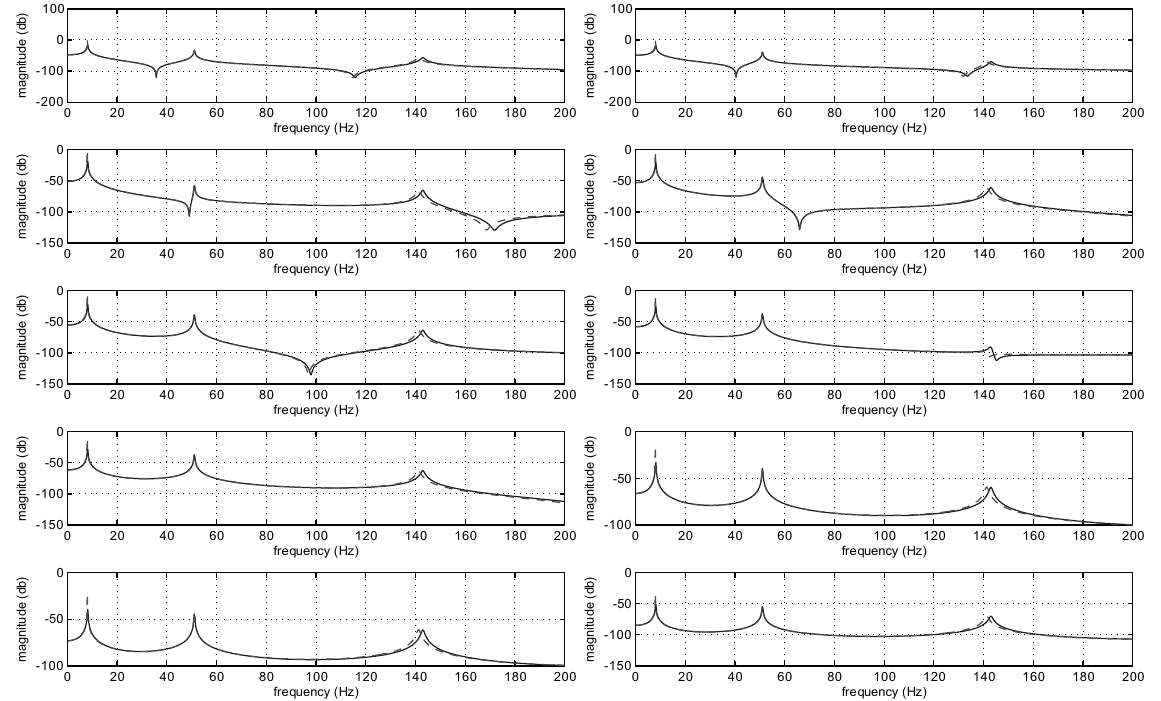
Fig. 3. Response functions for undamaged (full line) and damaged (dashed line) case, with response in DOF 1 (top left), DOF 2 (top right) ... DOF 10 (bottom right).